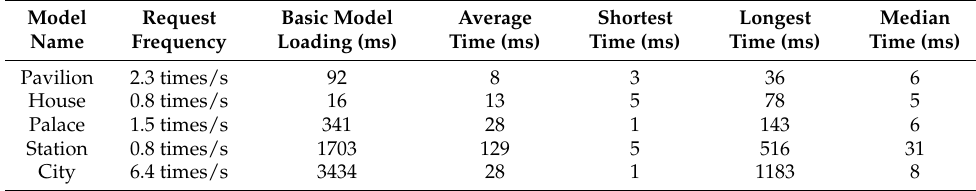
Table 4. Frame rate statistics on